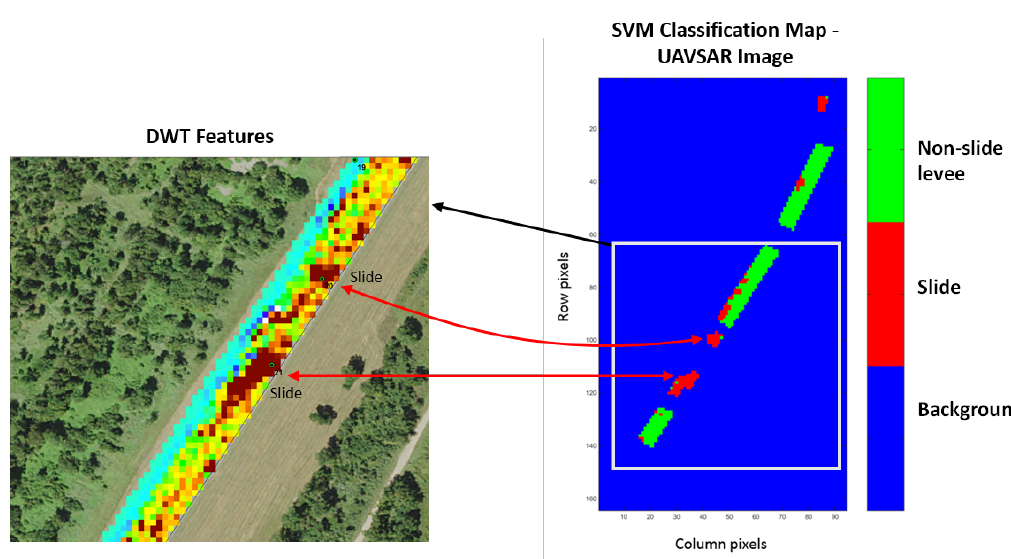
Figure 7. SVM Classification. The SVM Classification map for UAVSAR data set using DWT features with σ = 0.08 and wavelet block size B = 8 (window is B × B ) is shown on the right. On the left is a enlarged overlay of the wavelet features (with an aerial image background).